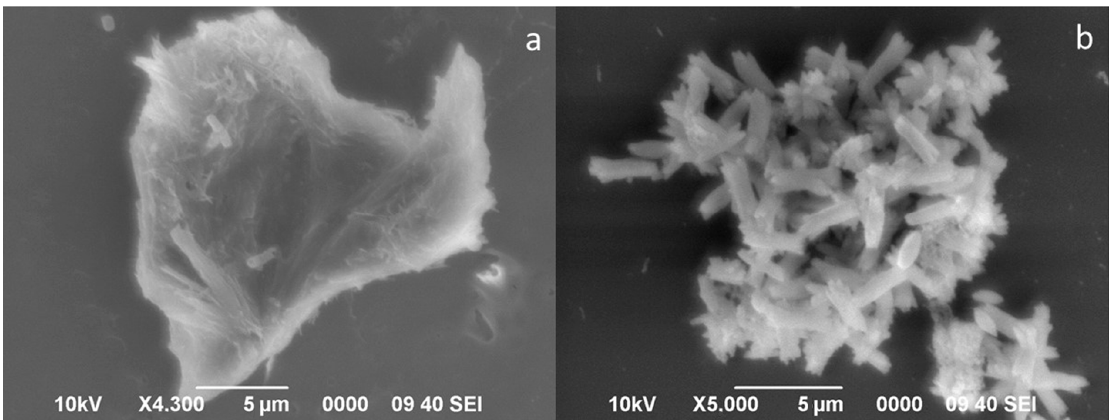
Figure 13. SEM images of Salmonella units adsorbed on the external surface of palygorskite ( a ) and pal-PCH ( b ).